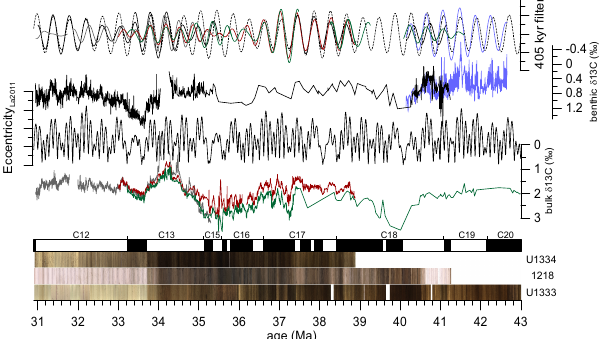
Figure 10. Tuned bulk and benthic stable carbon isotope data plot- ted against La2011 orbital solution for eccentricity (Laskar et al., 2011b). Bulk data: 1218 (gray; Pälike et al., 2006), U1333 (green; this paper; Wilson et al., unpublished; Leon-Rodriquez and Dick- ens, 2013), U1334 (red; this paper; Wilson et al., unpublished). Benthic data: 1218 (black; Lear et al., 2004; Coxall et al., 2005; Tripati et al., 2005; Coxall and Wilson, 2011), 1260 (blue; Edgar et al., 2007). Long eccentricity (405kyr) band pass filters of the de- trended, tuned records are plotted on top La2011 (dash line). Mag- netostratigraphy as provided in Table 1 and combined core images from Site U1333, U1334, and 1218 for